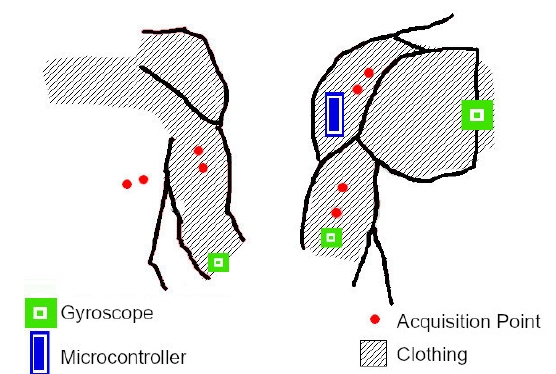
Figure 4. Design of the wearable suit to contain the electromyographic sensors and gyroscopes.